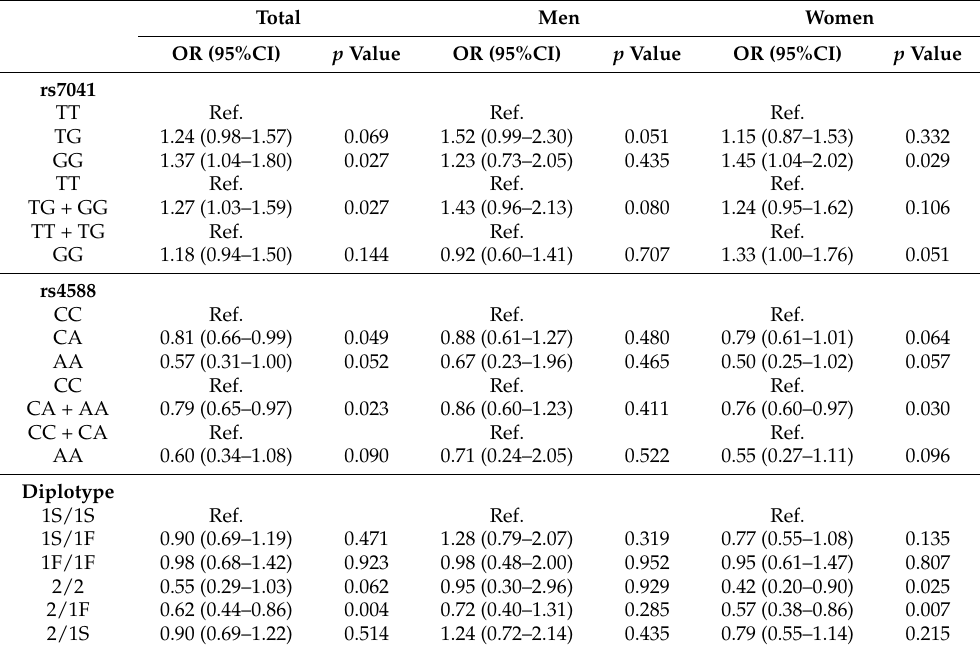
Table 2. Association of GC variants with metabolic syndrome stratified by sex. Total Men Women OR (95%CI) p Value OR (95%CI) p Value OR (95%CI) p Value rs7041 TT Ref.